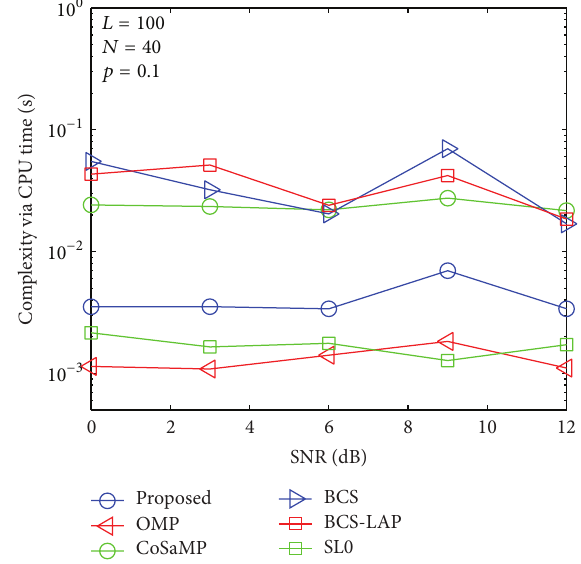
Figure 15: Computational complexity comparison via CPU time when 𝑝 1 = 0.1 and 𝑁 = 40